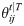
Comparison of model interactions with synapses in the balanced network.The synaptic structure is reflected in the inferred interactions. A Histograms of the interactions θijt|T for all pairs (gray), pairs that are connected by at least one excitatory synapse (red), and those that are connected by at least one inhibitory synapse (blue) at three different time points. B Averages of the couplings θijt|T across time and pairs as a function of a network size (always consisting of two thirds of excitatory and one third of inhibitory neurons). Colors as in A, and error bars denote standard deviations.